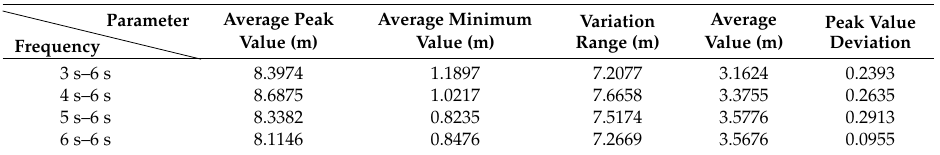
Table 2. Pressure values and statistical analysis after air inflow has been cut off for 6 s (round nozzle on top of the pipe).